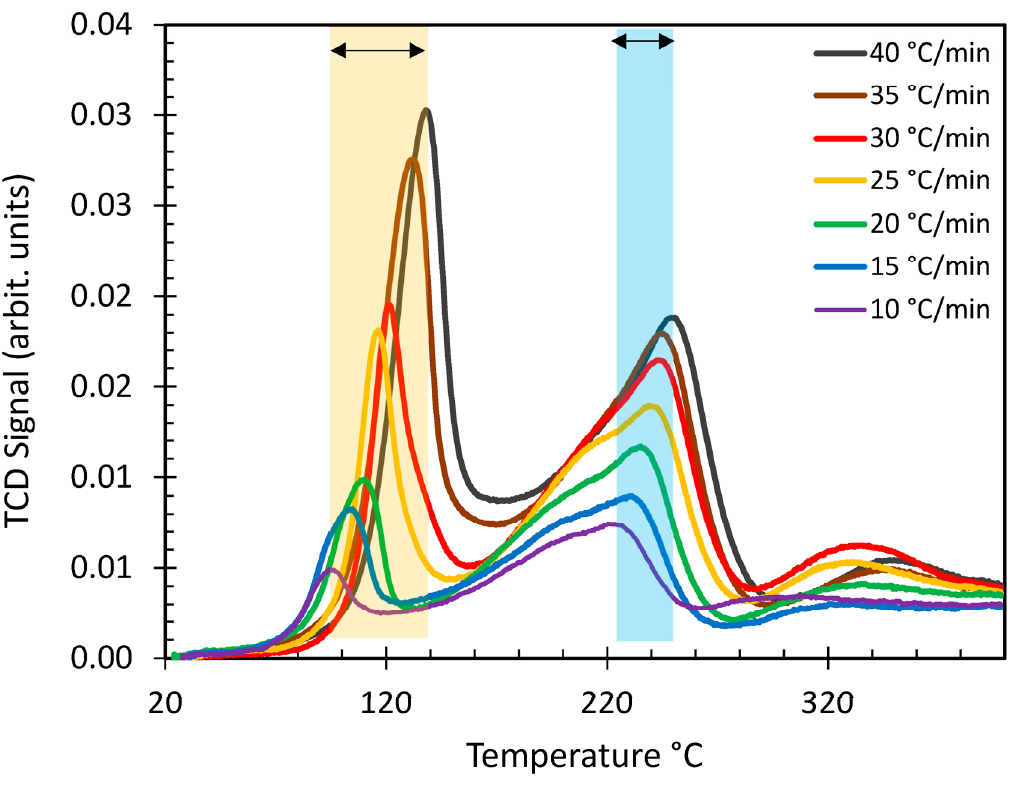
Figure 2. TPR patterns of 3.5 wt.% IrO 2 -TiO 2 (anatase, BET surface area = 55 m 2 /g) sample at different